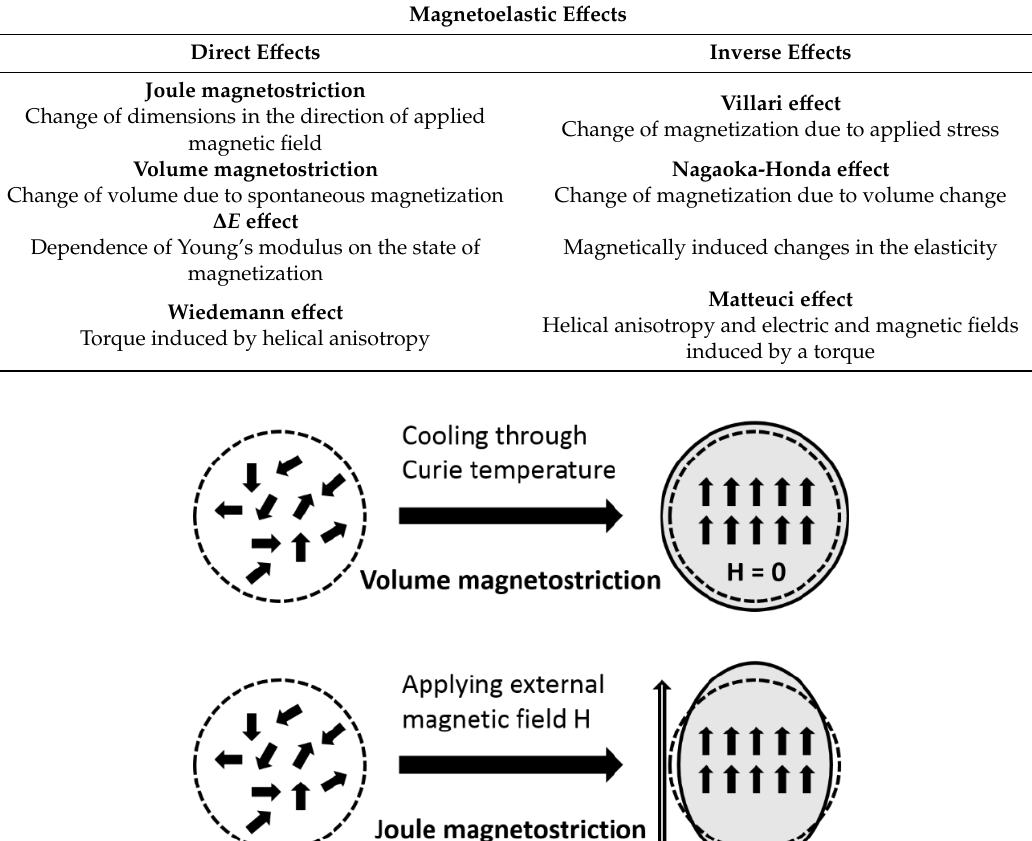
Table 3. Classifications of magnetoelastic e ff ects.